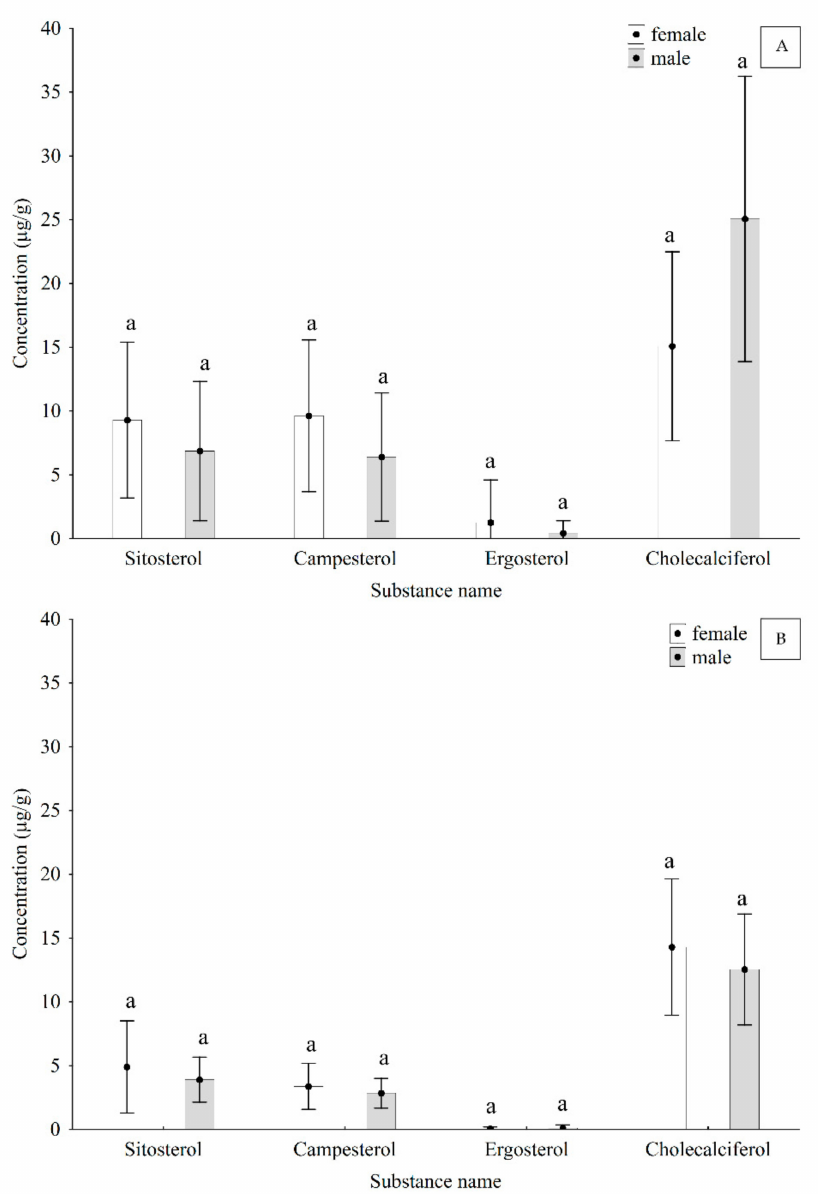
Figure 3. Mean ( ± SD) concentration of sterols (method with KOH derivation) differentiating the sexes of I. typographus ( A ) and P. chalcographus ( B ) isolated from adult specimens (the number of samples for each insect species was N = 12). The names of some substances are expressed as synonyms. Sitosterol = β sitosterol; campesterol = (3. β ., 24R) ergost-5-en-3-yl; and ergosterol = ergosta-5.7.22-trien-3 β -yloxy. For each substances bars with the same letter do not differ